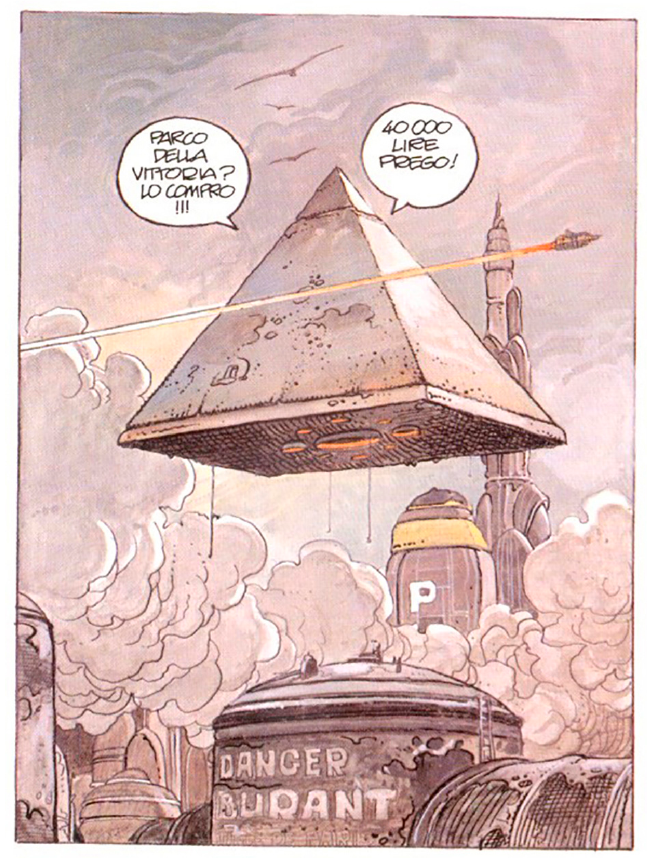
Figure 8. Henki Bilal, La Foire aux immortels,